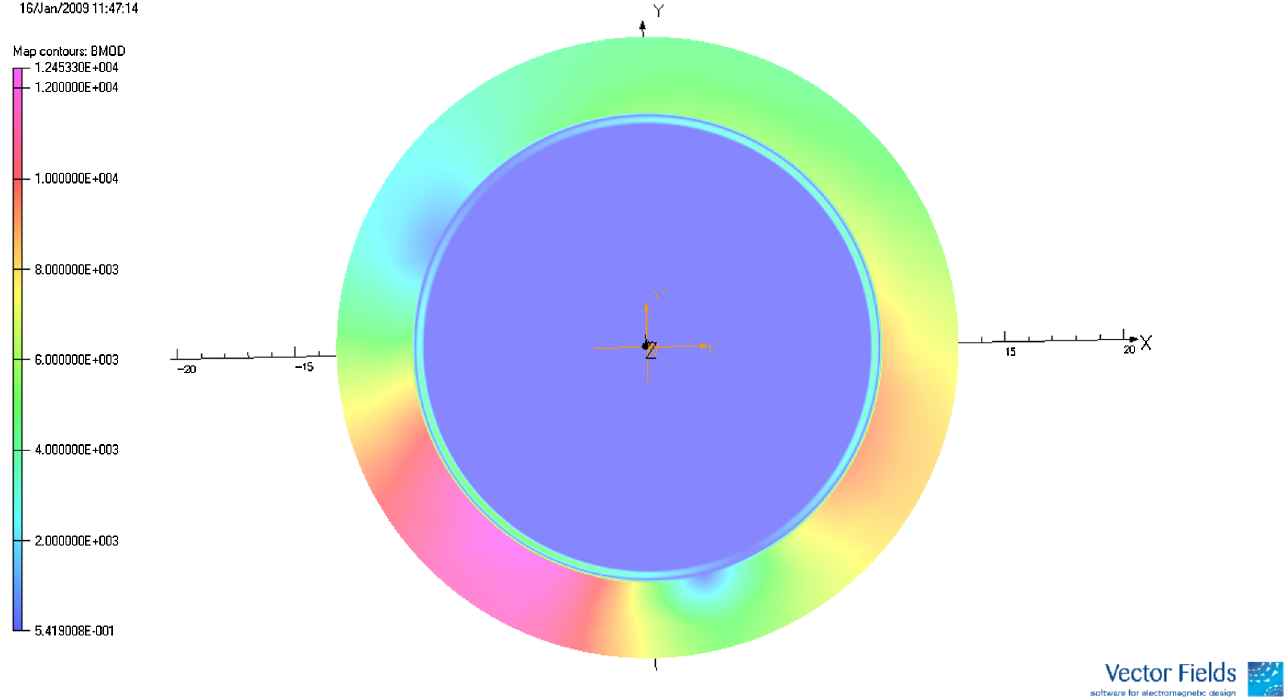
FIG. 4. (Color) Magnetic field across circulating beam aperture at magnet